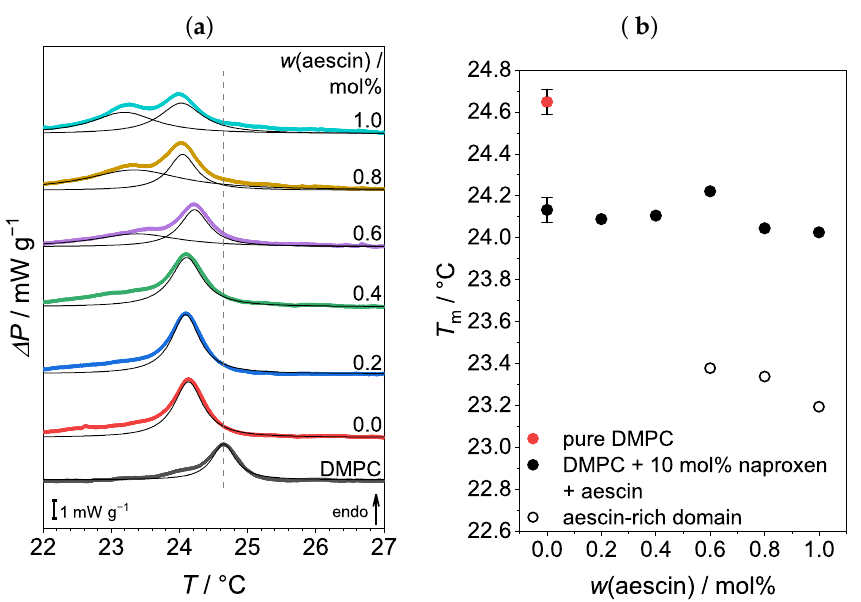
Figure 2. ( a ) Endothermic DSC thermograms of vesicles containing DMPC, 10mol% naproxen, and different amounts of aescin. The black lines show the Lorentzian fits to determine the maxima of the measured signals. The dashed gray line indicates the T m of pure DMPC vesicles at ( 24.64 ± 0.06 ) °C. The addition of naproxen induced a shift of T m to lower temperatures. Aescin amounts from 0.6mol% and higher led to the appearance of a second peak below T m . ( b ) The plot of T m of the DMPC lipid membrane and the aescin-rich domains against w (aescin). As an example, the error bars for two data points are given. For the sake of clarity, the other data points were plotted without error bars.